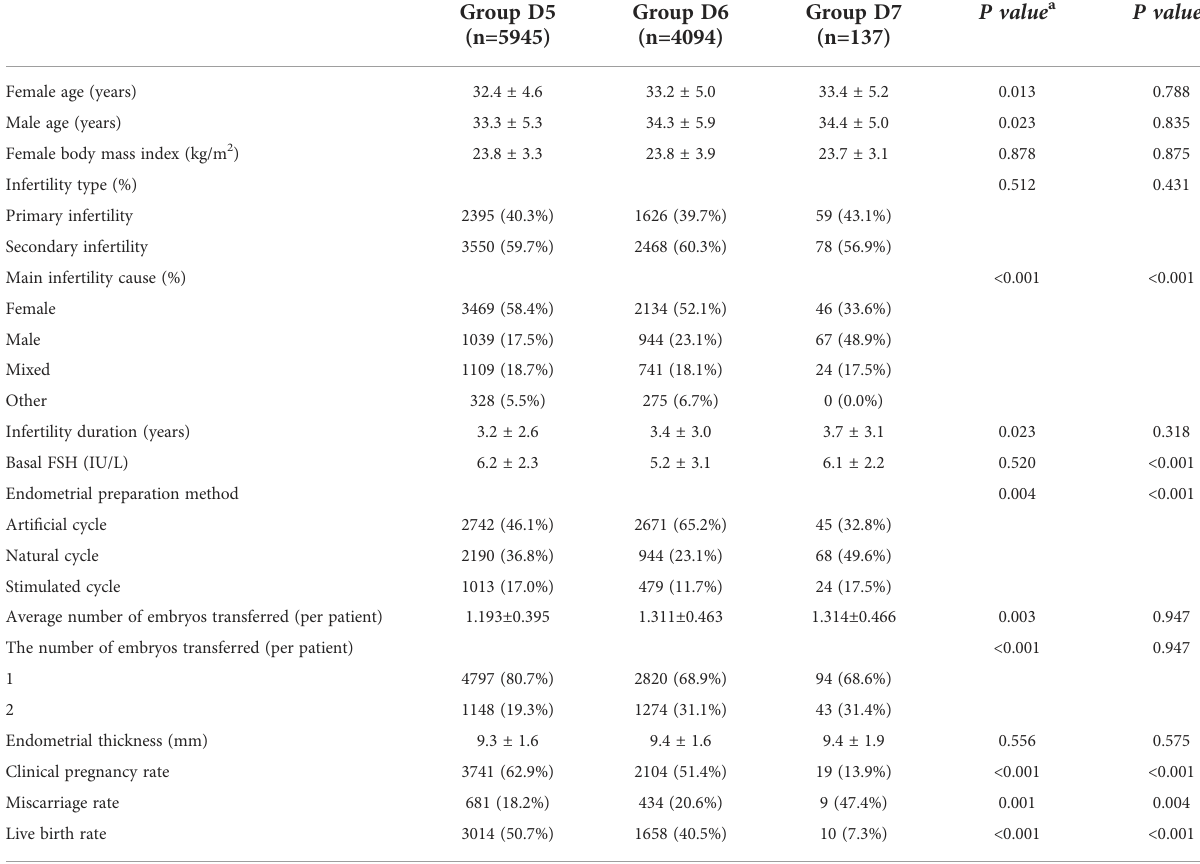
TABLE 1 Comparison of basic clinical data and clinical outcomes among the three